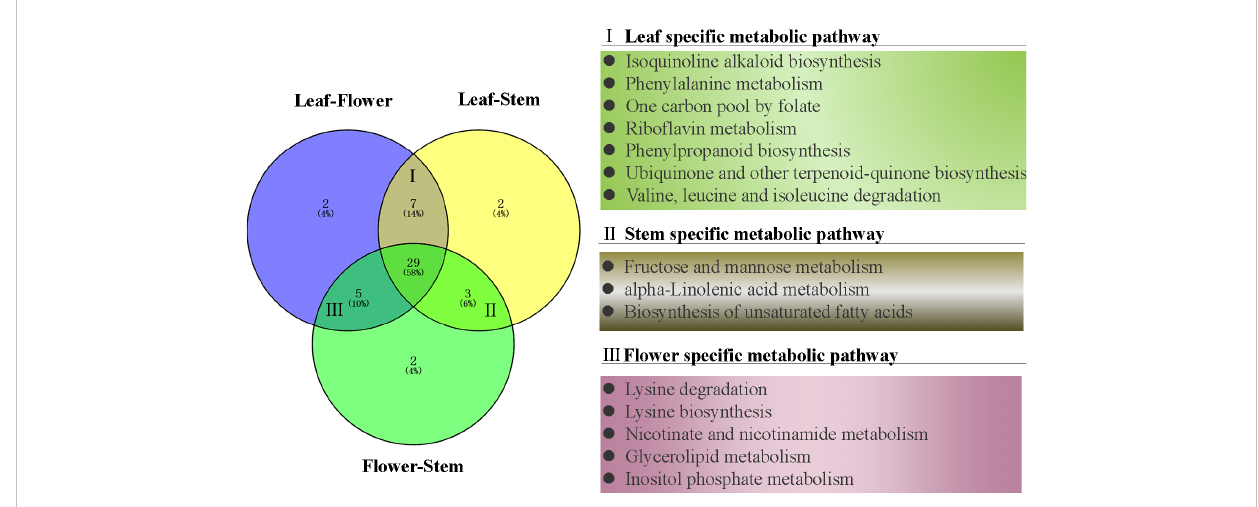
FIGURE 4 The venn diagram of differential metabolic pathways in P. cablin. The pathways were referenced in kyoto encyclopedia of genes and genomes